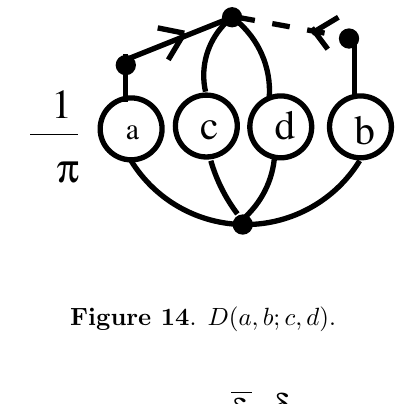
Figure 14 . D ( a; b ; c; d ).